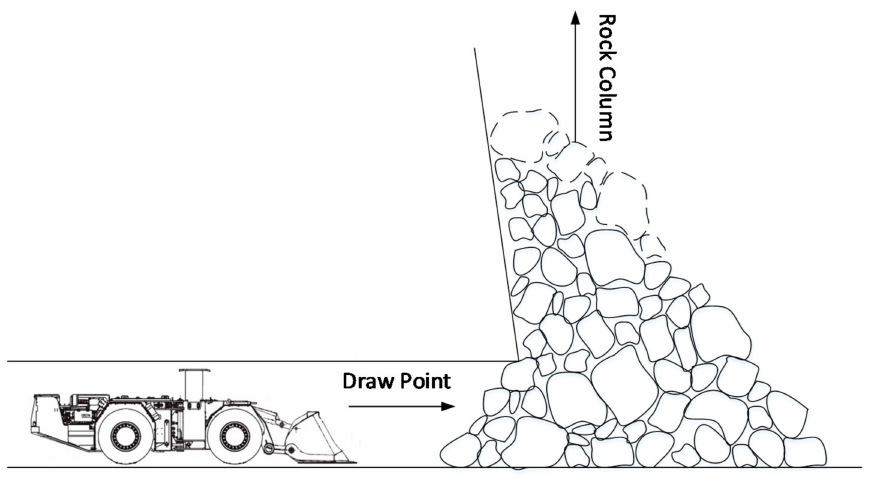
Figure 3. Sublevel stoping draw